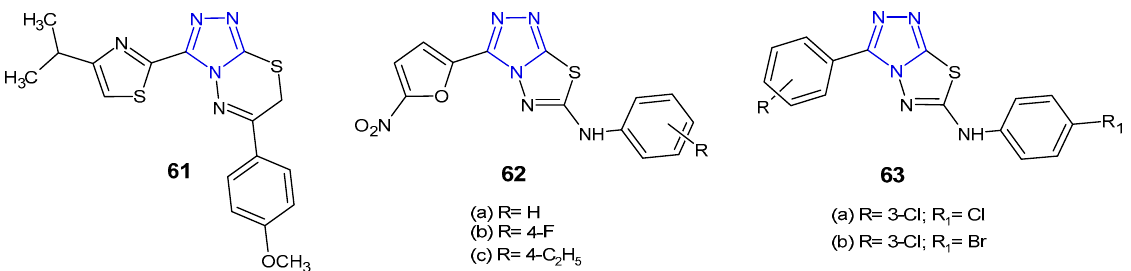
Figure 19. Antibacterial derivatives of 1,2,4-triazolo [3,4-b][1,3,4]thiadiazoles and 1,2,4-triazolo [3,4-b][1,3,4]thiadiazines.